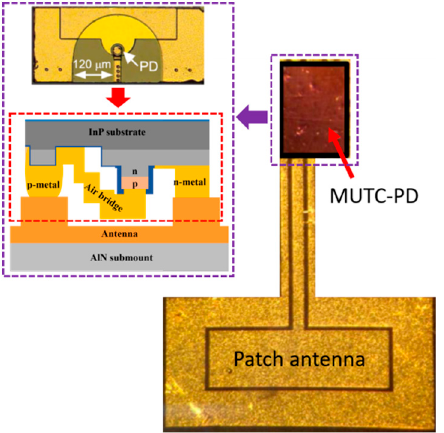
Figure 4. Schematic and optical image of the integrated photodiode-antenna emitter. A 50- Ω transmission line connects the patch antenna (829 µ m × 2668 µ m) and the flip-chip bonded MUTC PD